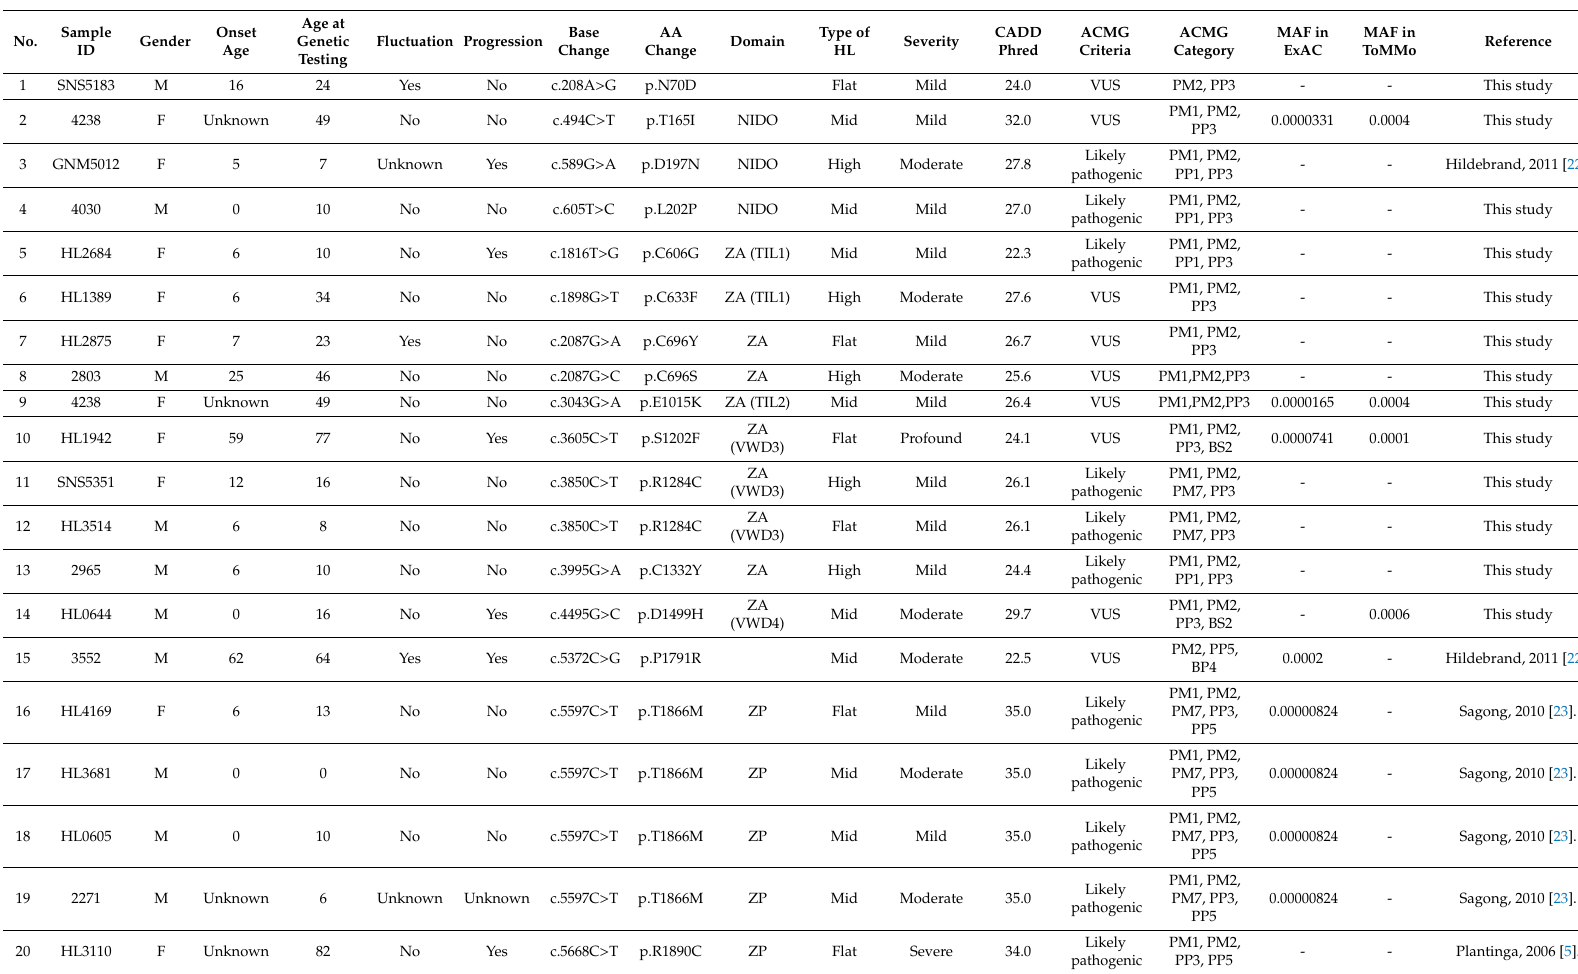
Table 1. Summary of the clinical features and information of the likely pathogenic and candidate variants classified as VUS identified in this